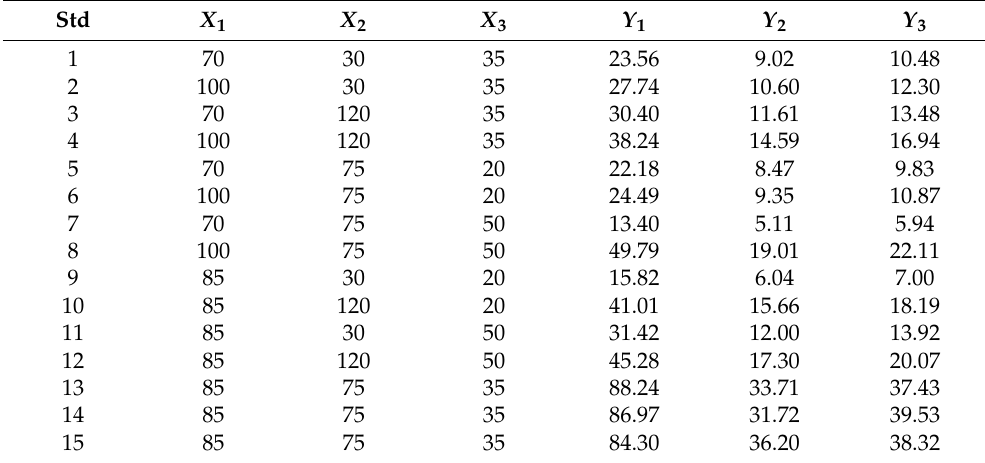
Note: Values expressed as mean value, n = 3. After ANOVA analysis for three response models, the results showed the solvent-to- material ratio had a non-significant effect on all response surfaces because their p -value was 0.9527, 0.9606, and 0.9521, corresponding to surface Y 1 , Y 2 , and Y 3 , respectively. Interaction factors of x 1 x 2 and x 2 x 3 possessed a p -value higher than 0.05, showing that these interaction factors did not affect the response surfaces (Table 3). The results also showed the coding variable equation of response surface Y 1 , Y 2 , and Y 3 , as follows: